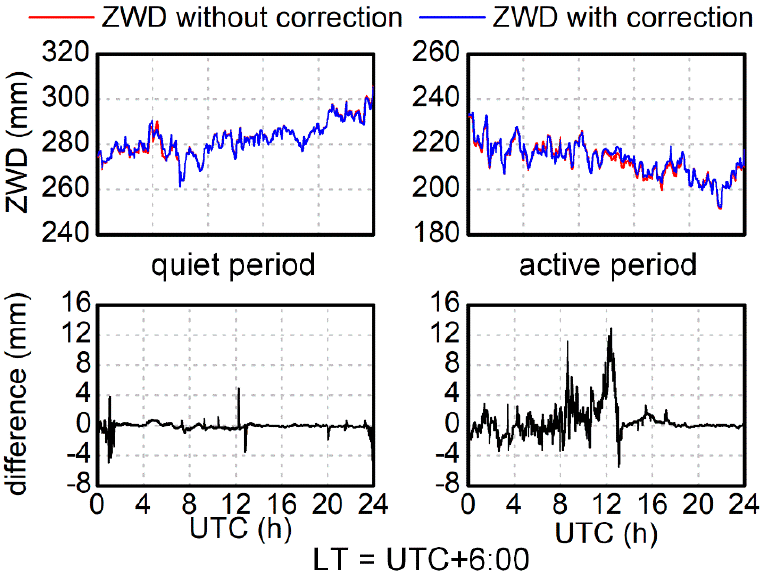
Figure 8. The ZWD estimates ( top ) with and without HOI corrections and their differences ( bottom ) for station COCO during the quiet and active period.